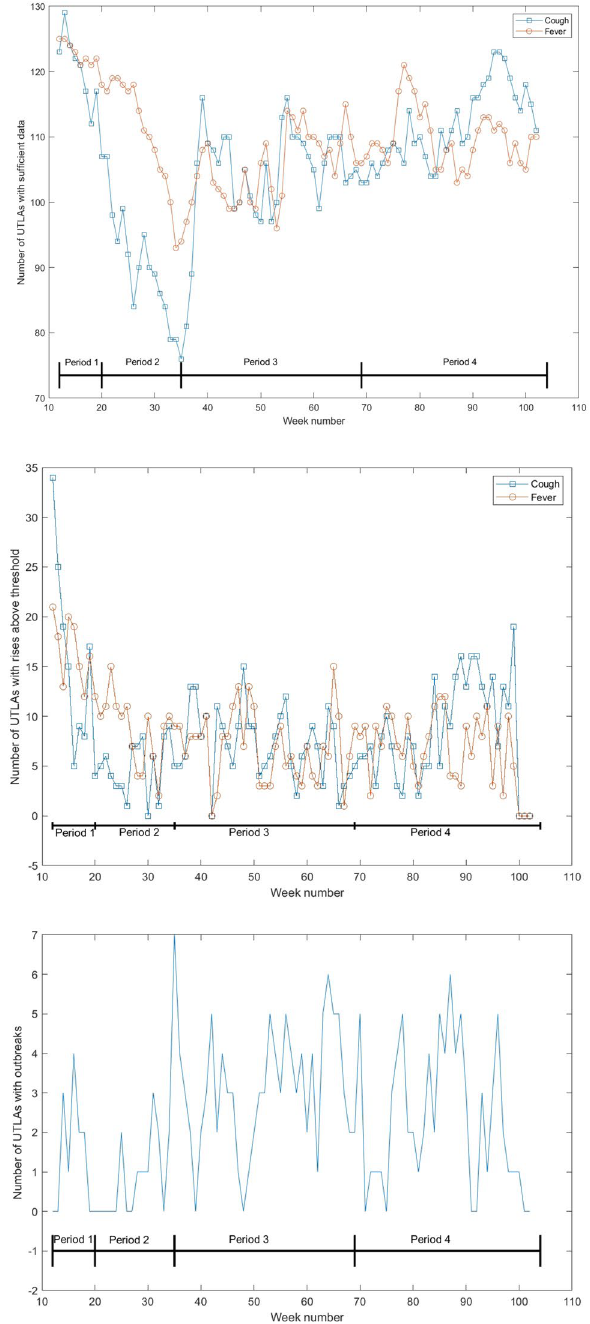
Figure 3. Number of UTLAs with sufficient Bing data over time (top), number of UTLAs with values over the threshold over time (middle) and number of UTLAs with an anomaly (as defined in the “Methods” section) (bottom). Week numbers correspond to the weeks since the beginning of 2020. The periods marked are: (1) March 1st to May 31st. 2020, (2) June 1st to August 31st, 2020, (3) September 1st, 2020 to April 30th, 2021,